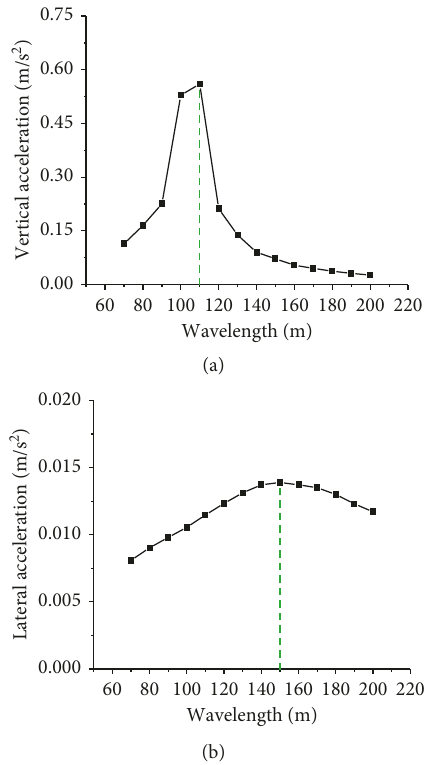
Figure 10: Vehicle dynamic responses. (a) Vertical acceleration. (b) Lateral